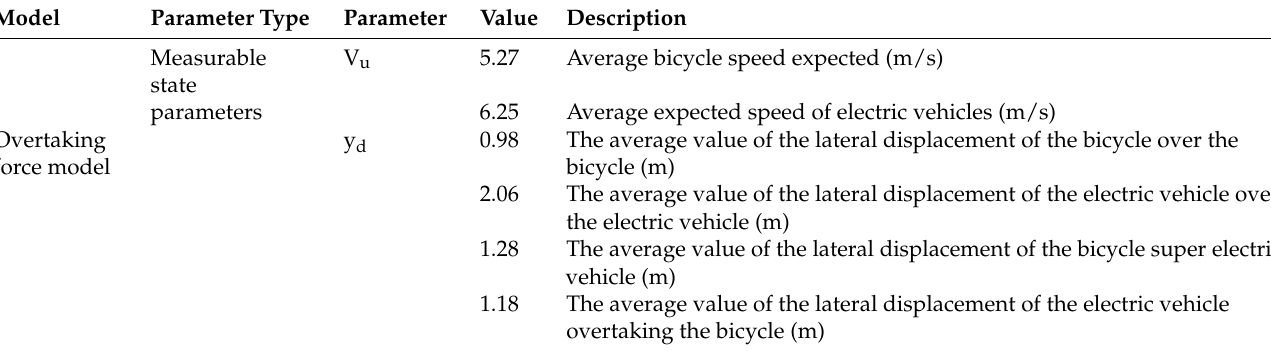
Table 2. Measurable state parameters and calibration